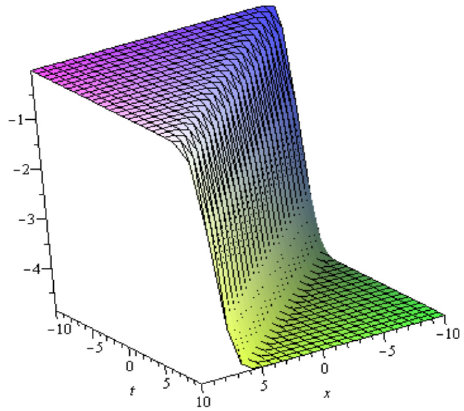
Figure 1. The solitary wave 3D graphics of Equation (24) shows a kink shaped soliton profile for, A 0 “ 1, m “ 1, ω “ ´ 1, k 1 “ 1, k “ 2, l “ 2, A “ 2, B “ 3, µ “ 1, λ “ 3, E “ 1 within the interval ´ 10 ď x , t ď